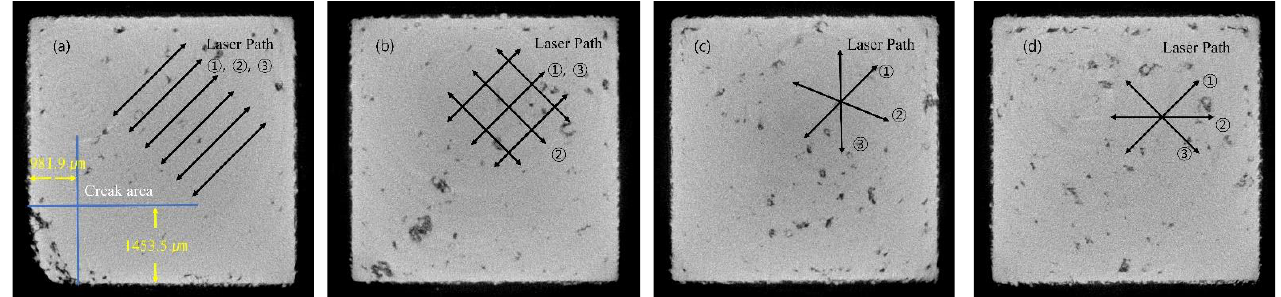
Figure 9. CT scan results at a height of 1 mm from the base plate: ( a ) same direction (180°); ( b ) 90° rotation; ( c ) 67° rotation; ( d ) 45° rotation.